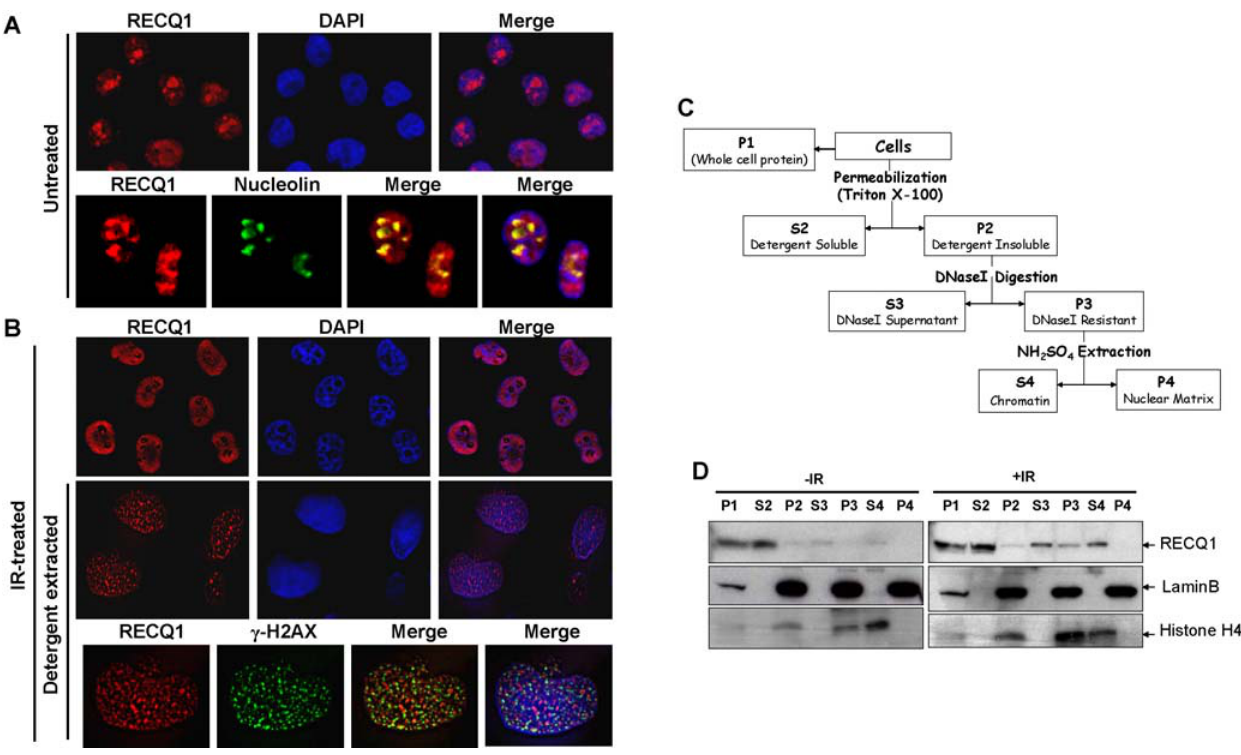
Figure 1. Nucleolar RECQ1 undergoes re-localization to chromatin in response to IR. Indirect immunofluorescence was performed on HeLa cells that were either untreated or allowed to recover for 6 h from 10 Gy IR exposure as described in ‘‘Materials and Methods’’. Panel A , Nucleolar localization of RECQ1 in untreated cells. Cells were co-immunostained with anti-RECQ1 and anti-nucleolin. The merged images show cells stained with RECQ1 (red) and nucleolin (green), with or without DAPI (blue). Panel B, Relocalization of RECQ1 to chromatin-bound foci following IR damage. After IR exposure, cells were stained for total RECQ1 (top panel) or in situ detergent extraction-resistant RECQ1 (middle and bottom panel). Merged images show RECQ1 (red) and DAPI (blue). Co-immunostaining of chromatin-bound RECQ1 and c -H2AX ( Panel B, bottom ). Merged images show RECQ1 (red) and c -H2AX (green), with or without DAPI (blue). Panel C, Schematic presentation of the protocol for sequential nuclear fractionation of lysates from U2OS cells either untreated or following 6 h recovery from 10 Gy IR exposure. Cytoplasmic and nucleoplasmic proteins were extracted by permeabilization with detergent, and the resulting nuclei were nuclease-digested and extracted with NH 2 SO 4 . Proteins of the supernatant (S) and pellet (P) fractions were resolved on 10% SDS-PAGE, and subsequently analyzed by Western blot for RECQ1, histone H4 (chromatin marker), and lamin B (nuclear matrix marker). Panel D, Following IR treatment, RECQ1 is enriched in the chromatin fraction (S4).